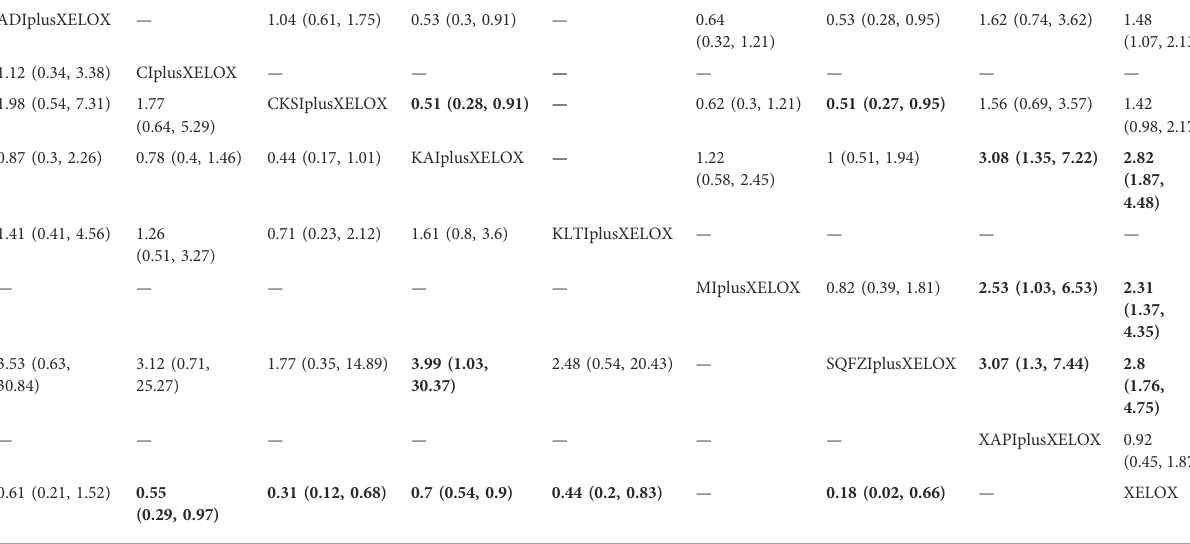
The values in bold are values with statistical analysis signi fi cance.